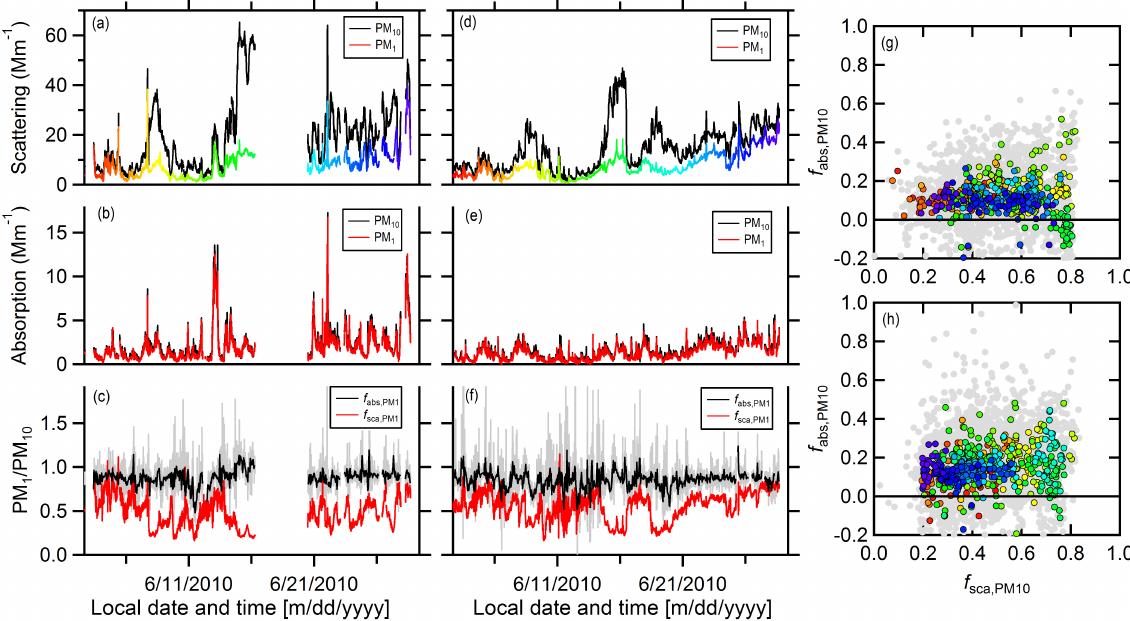
Figure 1. Time series of PM 1 and PM 10 scattering (a, d) and absorption (b, e) coefficients at 550nm for T0 (left panels) and T1 (right panels). Values for PM 10 are shown as black lines and for PM 1 as colored lines. The ratio between PM 1 and PM 10 scattering (red) and absorption (black) are shown in (c) and (f) . (For absorption, the data have been further averaged to 1h; the higher time resolution data are shown in gray.) The covariation between f abs , PM and f sca , PM for T0 (g) and T1 (h) are also shown. The 1h averaged points are colored 10 10 according to time during the campaign, and correspond to the time series in (a) and (d) ; the gray points are the data at higher time